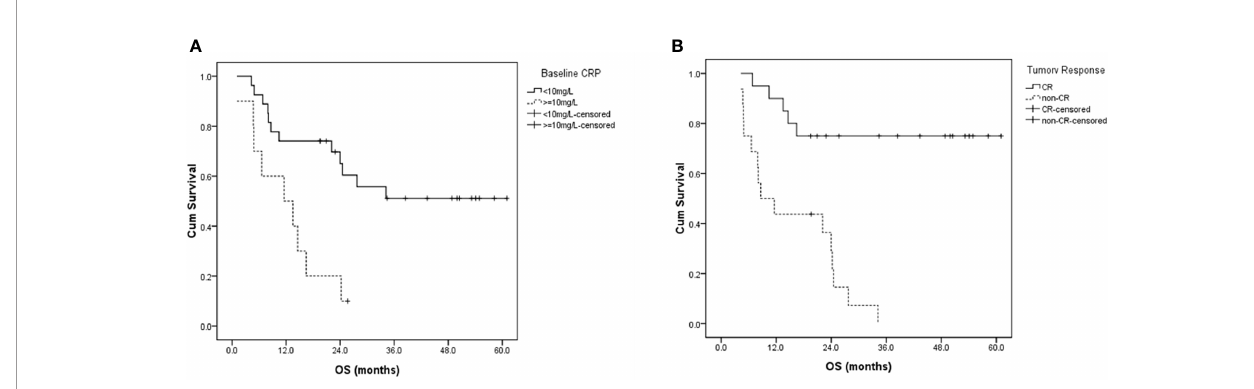
FIGURE 3 | Overall survival curves for patients with (A) different baseline CRP levels, and (B) different tumor responses two months after radiotherapy. CRP, C-reactive protein; CR, complete response; OS, TABLE 5 | Treatment related toxicities (n = 37). Toxicity Grade, No. (n/37%)